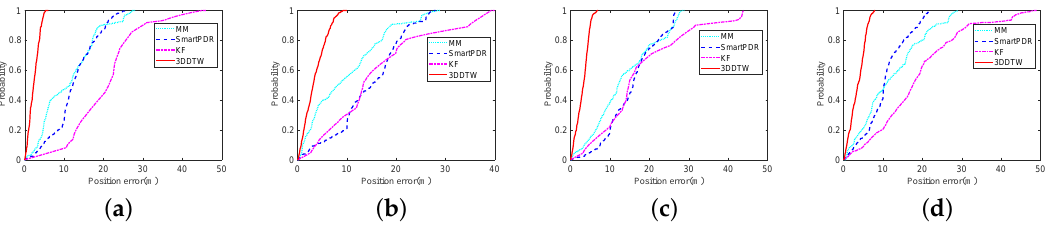
Figure 10. CDFs for MM, SmartPDR, KF, 3DDTW in study room: ( a ) calling; ( b ) dangling; ( c ) handheld; and ( d ) pocket. Table 2. Position errors for MM, SmartPDR, KF, and 3DDTW (m) in study